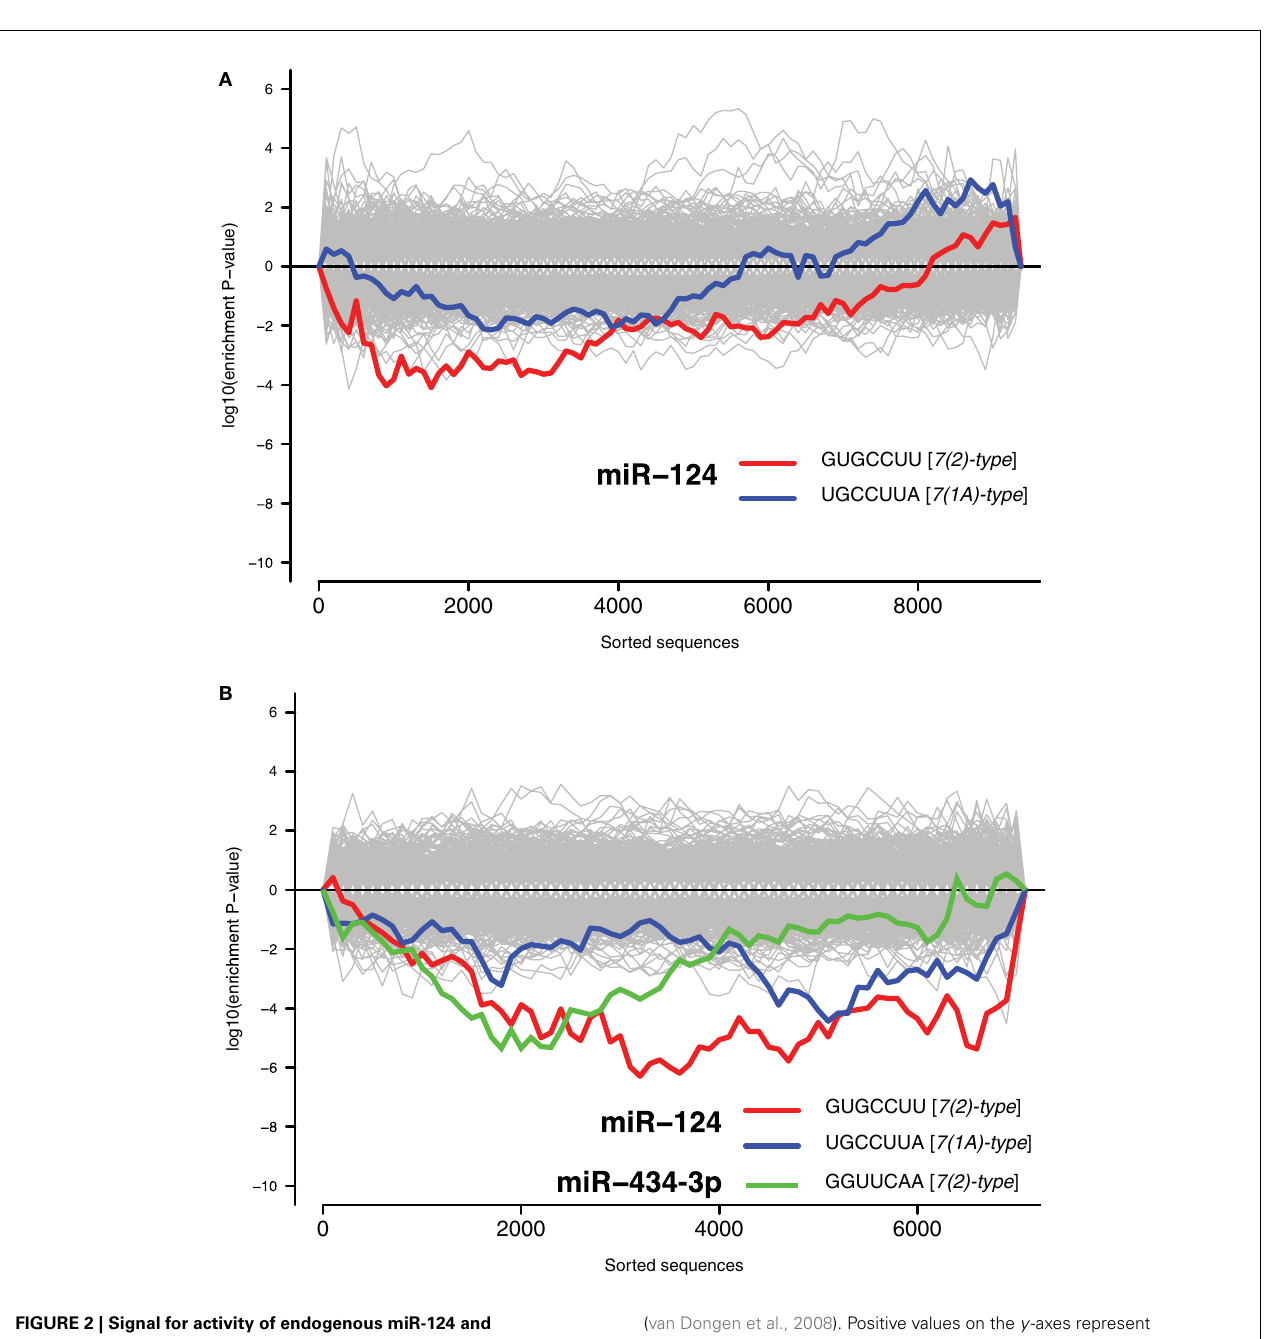
FIGURE 2 | Signal for activity of endogenous miR-124 and miR-434-3p. The x -axes represent 3 (cid:48) UTRs corresponding to expressed genes sorted from most downregulated to most upregulated in comparison of (A) cultures treated with KCl and untreated cultures and (B) mouse hippocampi treated with kainate and untreated hippocampi (Akahoshi et al., 2007). P -values are calculated using the Sylamer method